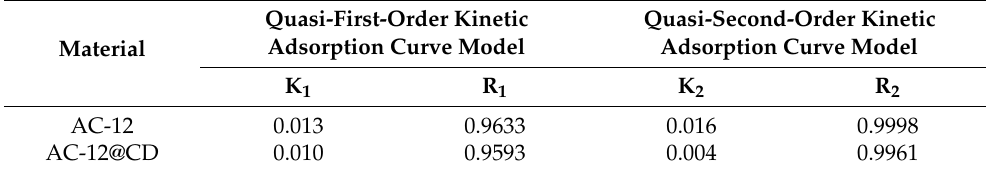
Table 4. Fitting parameters of adsorption kinetic